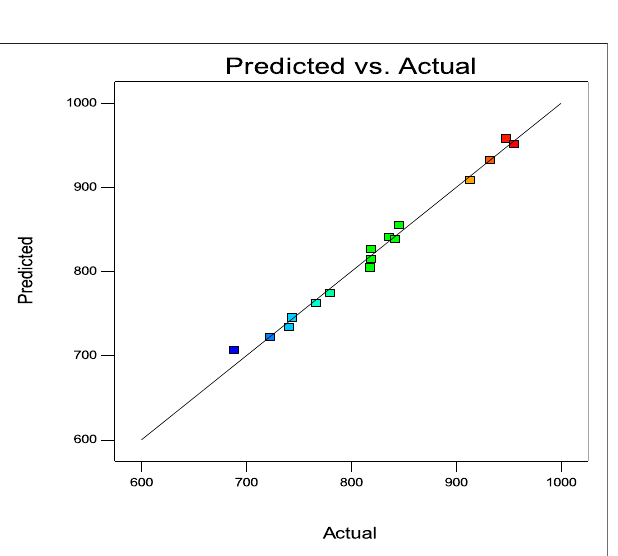
Frontiers in Energy Research |